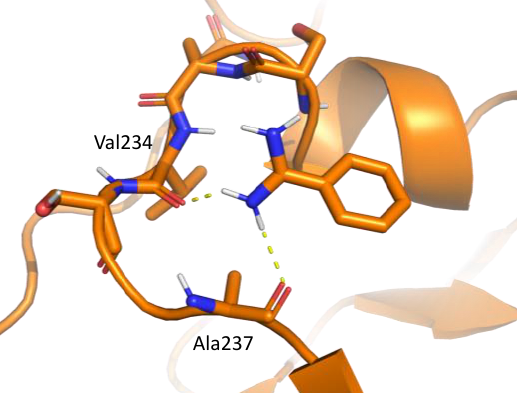
Figure 4. The residue interaction profile of benzamidine. Green, cyan, gray, blue, and red meshes indicate profiles of hydrophobic, hydrophilic, aromatic, basic, and acidic residues, respectively. The molecule structure is that of benzamidine.